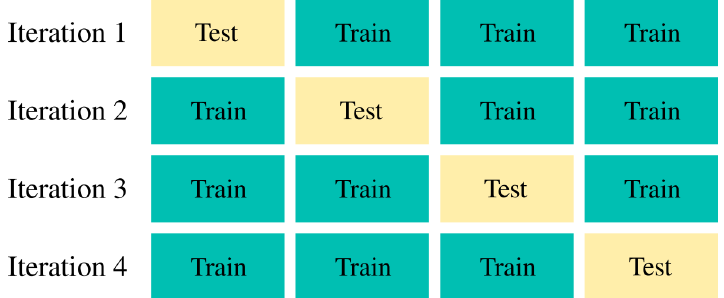
Figure 4. Splitting the database into 4 folds using